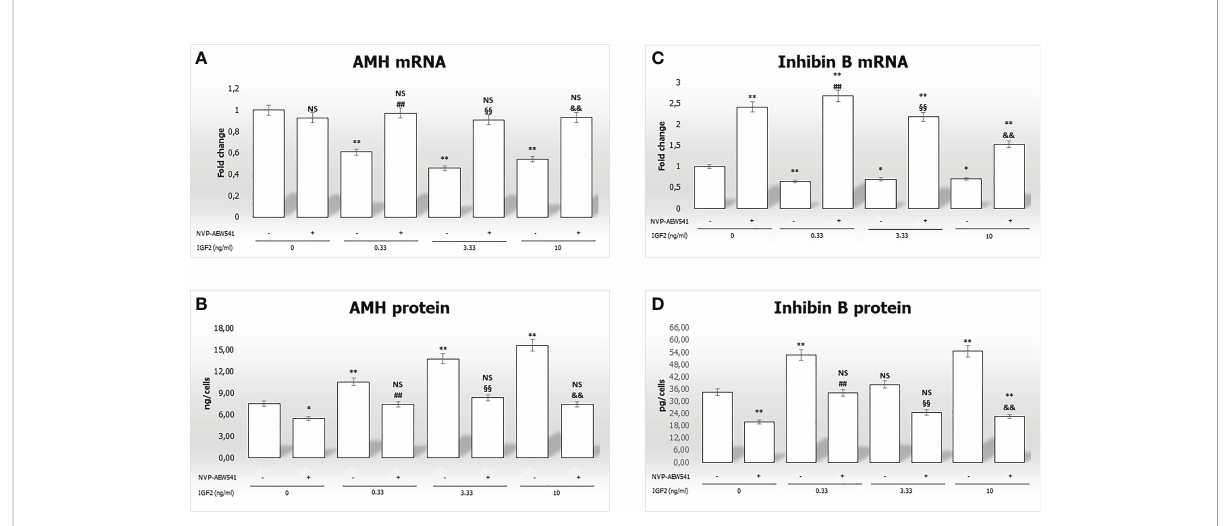
FIGURE 4 Anti-Müllerian hormone (AMH) and inhibin B gene expression and protein secretion. AMH mRNA and protein levels are shown in panels (A, B) , respectively. Inhibin B mRNA and protein levels are shown in panels (C, D) , respectively. Data represent the mean ± SD of three independent experiments, each performed in triplicate. Non-signi fi cant (NS) vs SCs, *p < 0.05 and **p < 0.001 vs SCs, ##p < 0.001 vs 0.33 ng/ml of rhIGF2, §§p < 0.001 vs 3.33 ng/ml, and &&p < 0.001 vs 10 ng/ml of